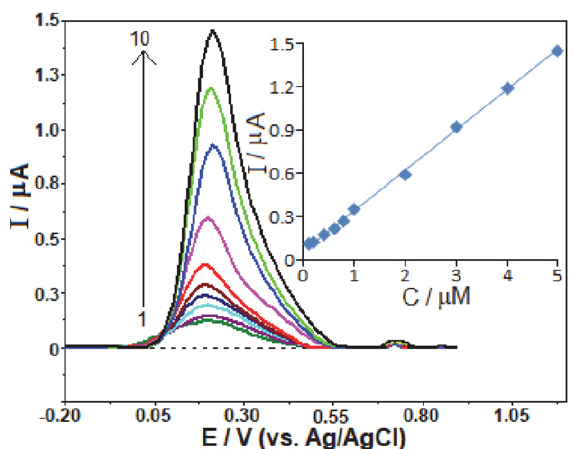
Figure 6. SW voltammograms for lawsone levels of (1) 0.1, (2) 0.2, (3) 0.4, (4) 0.6, (5) 0.8, (6) 1.0, (7) 2.0, (8) 3.0, (9) 4.0 and (10) 5.0 µM in 0.1 M phosphate buffer (pH 2.5) solution with 0.1 mM CTAB. Inset depicts a corresponding calibration plot for the quantitation of lawsone on APT-BDD electrode. SWV parameters: frequency, 75 Hz; step potential, 14 mV; pulse amplitude, 60